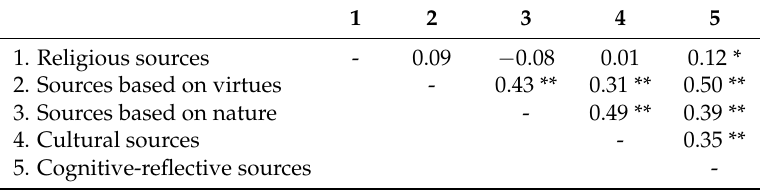
Table 4. Pearson’s product-moment correlation statistics between the use of sources of spiritual